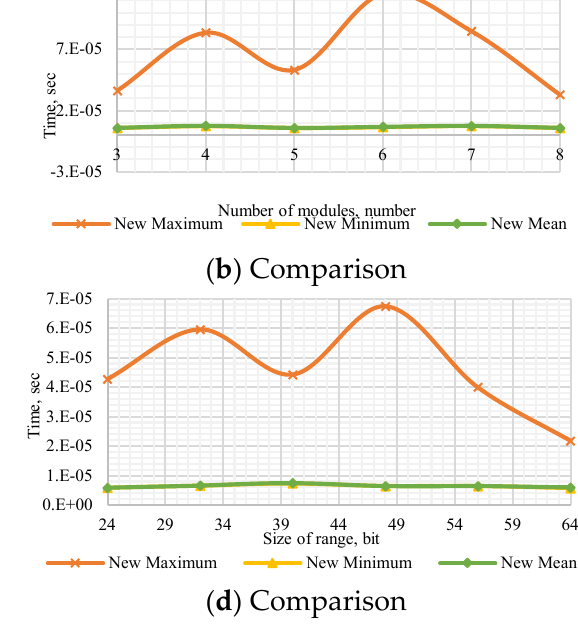
Figure A8. Performance of the DSN-EN method to ( a ) determine the number’s sign with a dynamic